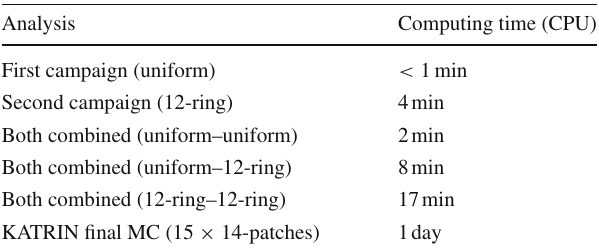
Table 3 Computing times for different analyses using the neural net- work. This includes the best-fit as well as an asymmetric error scan for the 1 σ errors in m 2 ν including systematic uncertainties with the nui- sance parameter approach. All computations are run on a single core and should only serve as rough estimates to prove the feasibility of